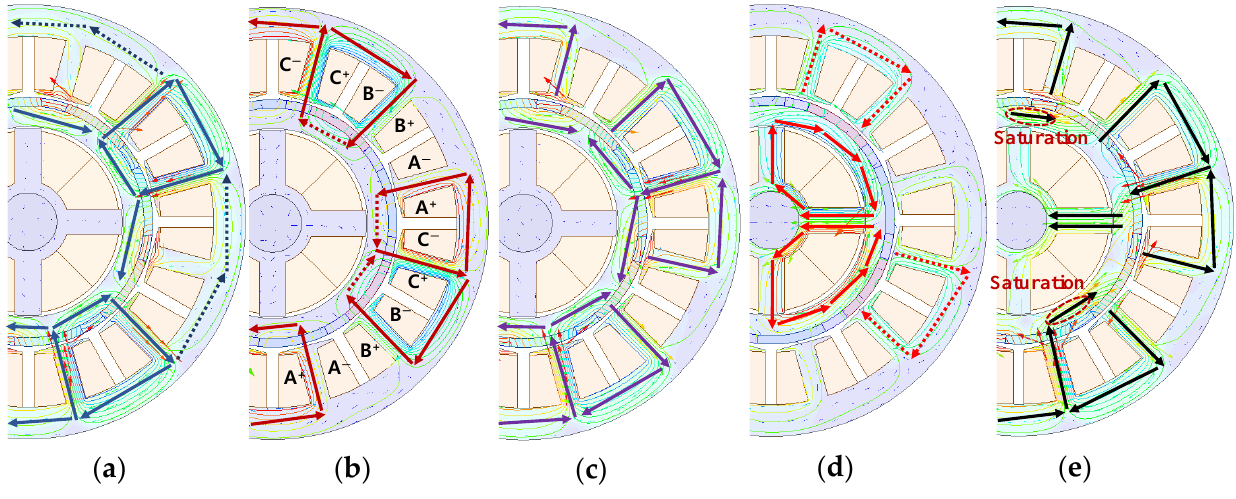
Figure 6. Flux line according to magnetomotive force at rotation angle 178° electric: ( a ) Magnet; ( b ) stator; ( c ) magnet, stator; ( d ) bearings; ( e ) bearings, magnets, and stators.